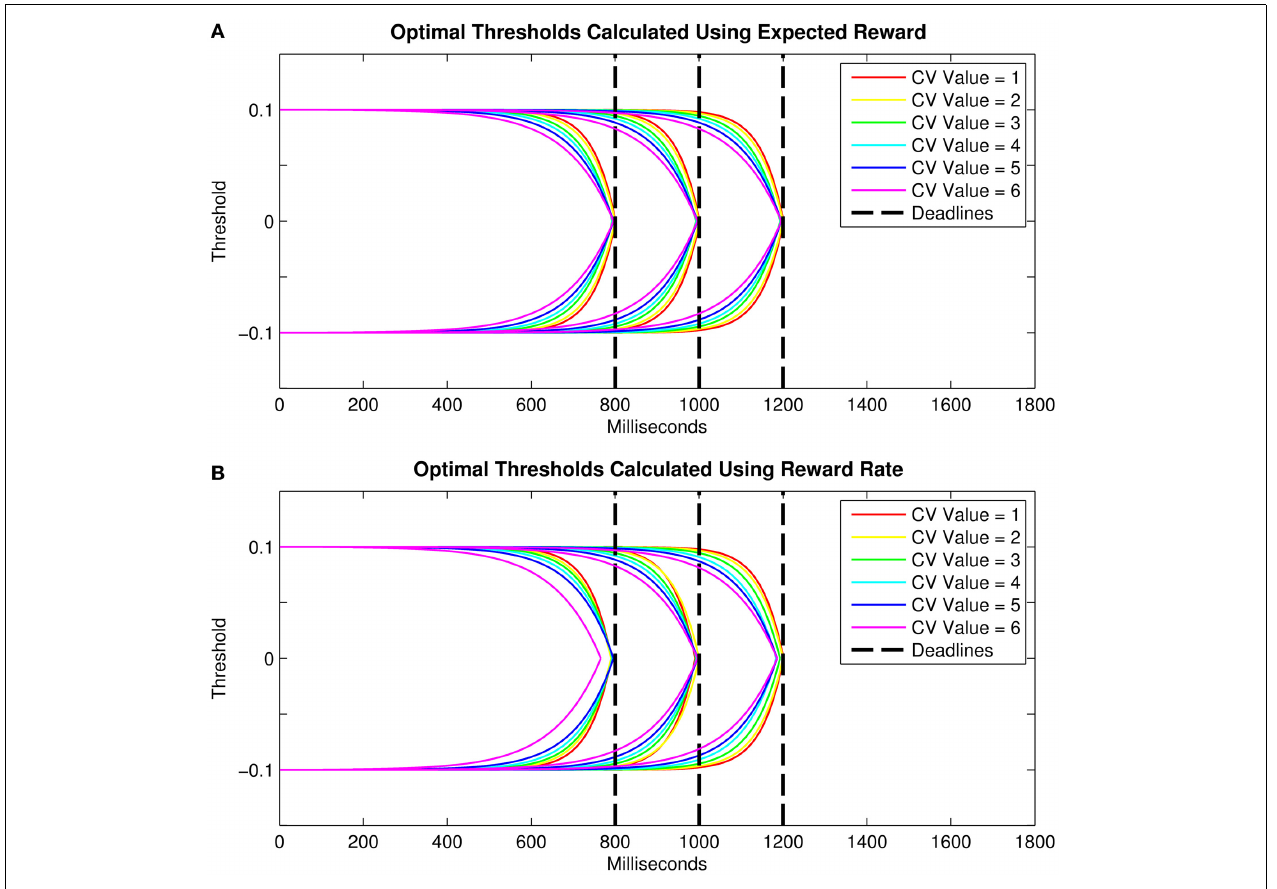
FIGURE 3 | Optimal threshold collapse trajectories selected from the family of exponential decline functions for three different response deadlines and six hypothetical levels of timing uncertainty when